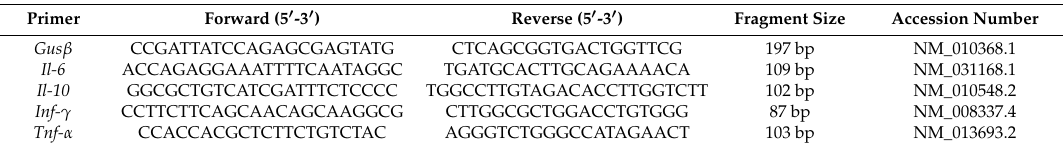
Table 2. The target gene transcripts were quantified using Glucuronidase β ( Gus β ) gene expression as ∆∆ CT a reference, using the 2 − method [15]. Product fidelity was confirmed by melt-curve analysis. Table 2. Primers used for real-time